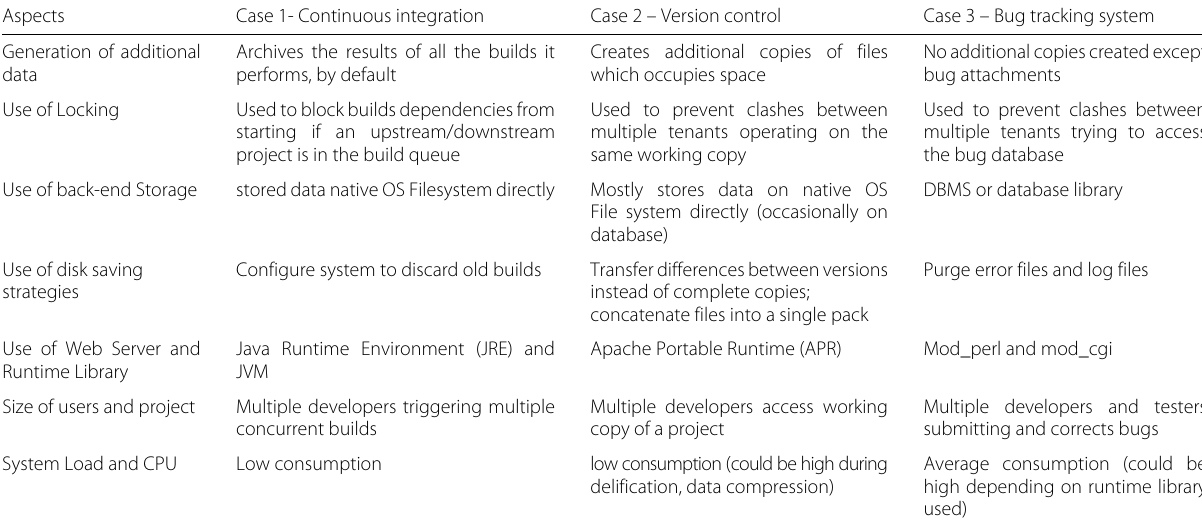
Table 8 Comparison of different aspects in which the Cases are